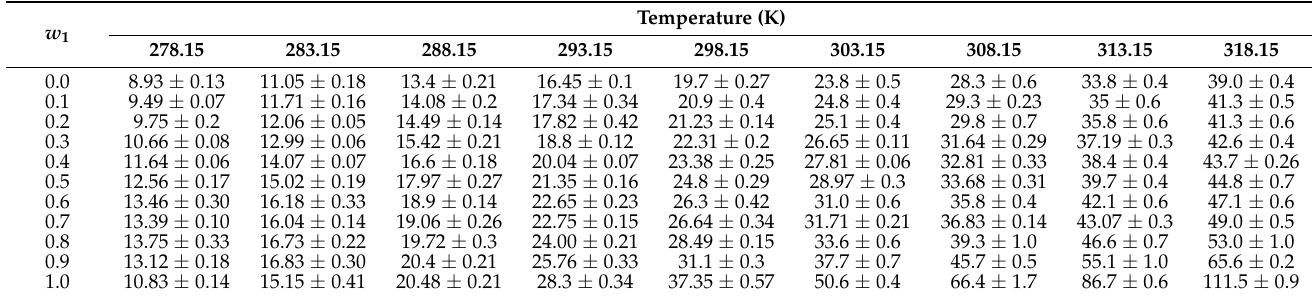
Table 1. Experimental solubility of isoniazid (3) in (PEG 200 (1) + water (2)) cosolvent mixtures